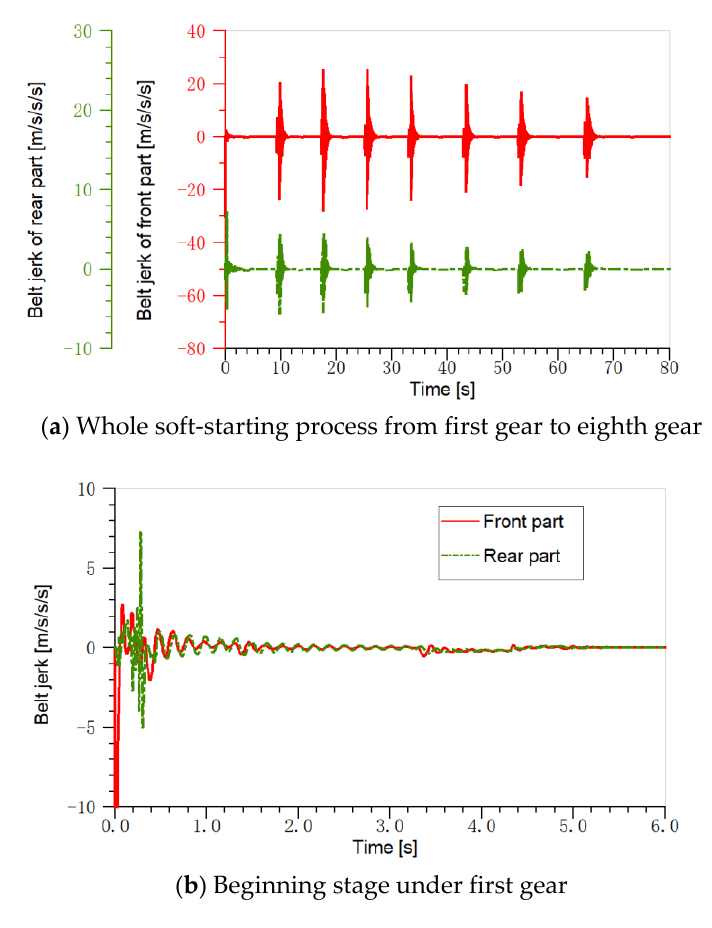
Figure 11. Belt jerk curve.